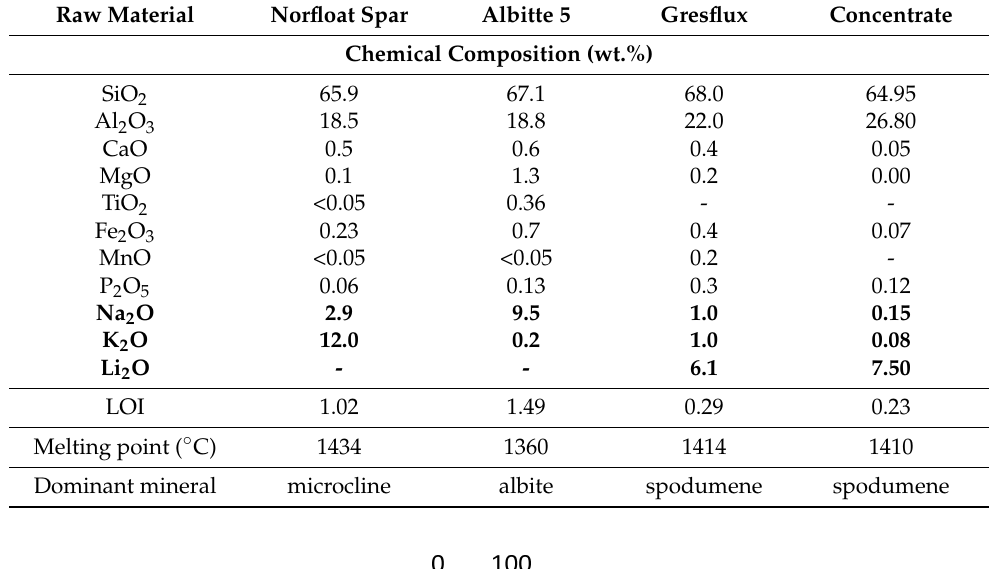
Table 2. Chemical composition and melting point of raw materials used.